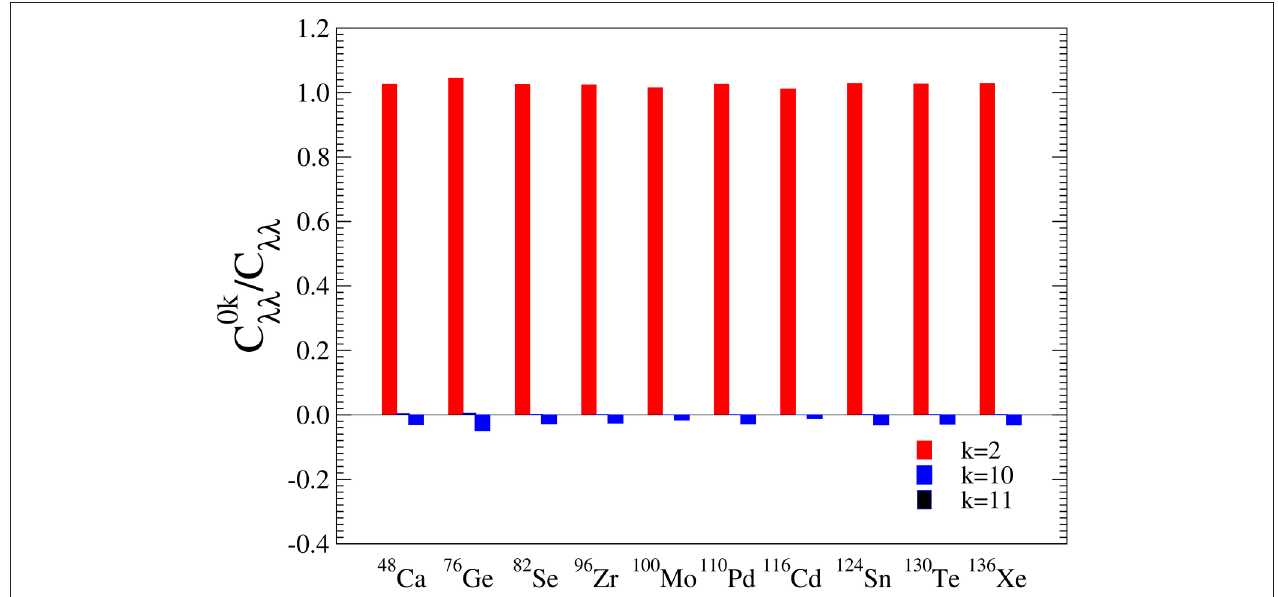
2, 10 and 11) for =